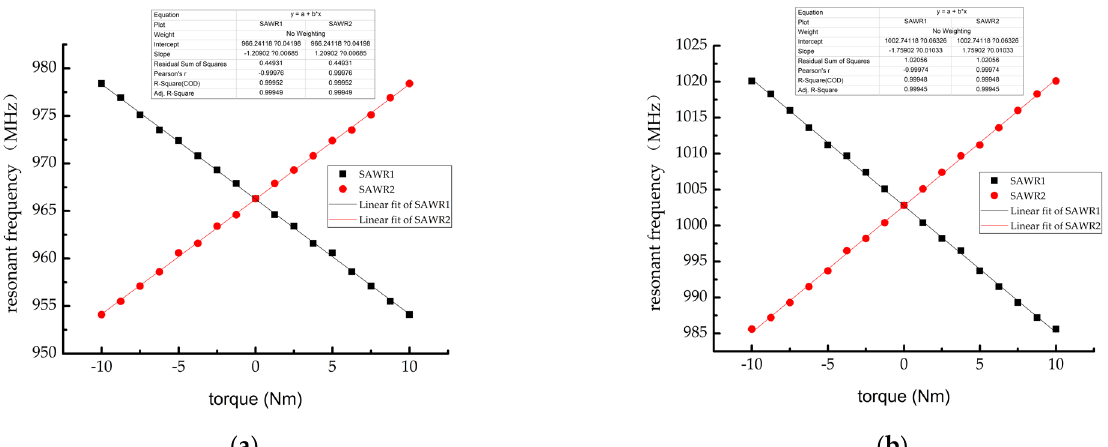
Figure 14. Variation curve of SAWR resonant frequency with sensor input torque ( a ) resonant frequency and ( b ) anti-resonant frequency.